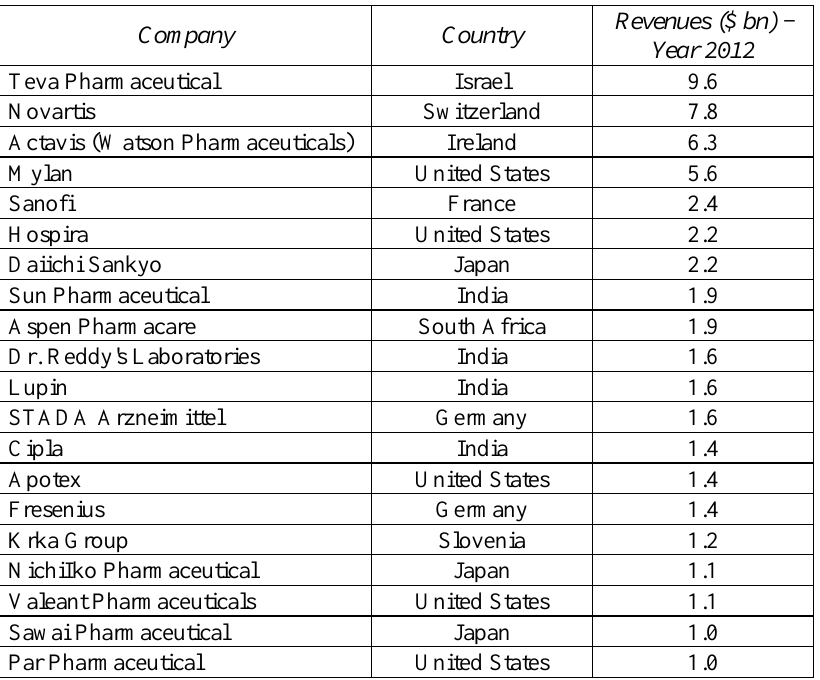
Table 2: Worldwide Generic Drug Sales in 2012. Top 20